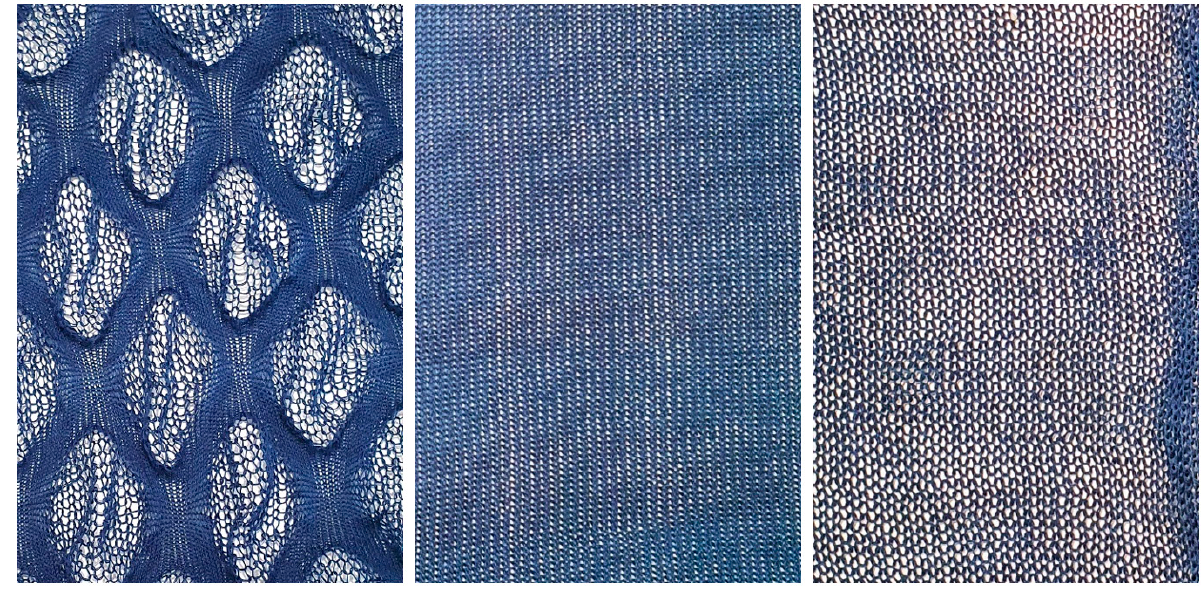
Figure 5. Comparison between drop-stitch 15% ( left ), the loose knit ( middle ) and the dense knit ( right ).